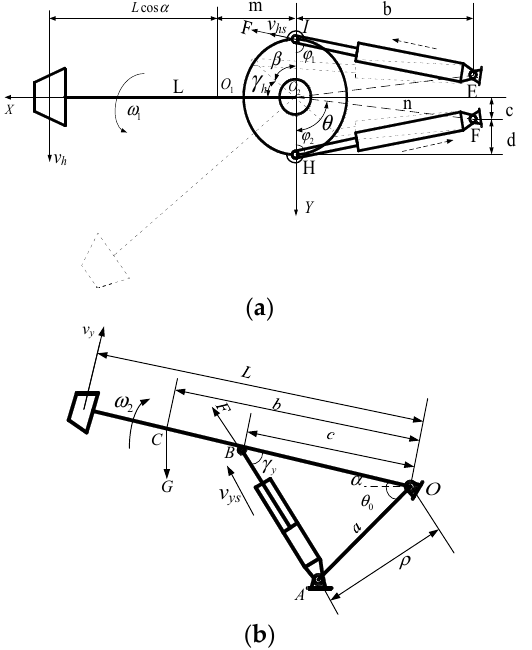
Figure 2. Schematic of cutting mechanism of roadheader: ( a ) horizontal swing; ( b ) lifting swing.